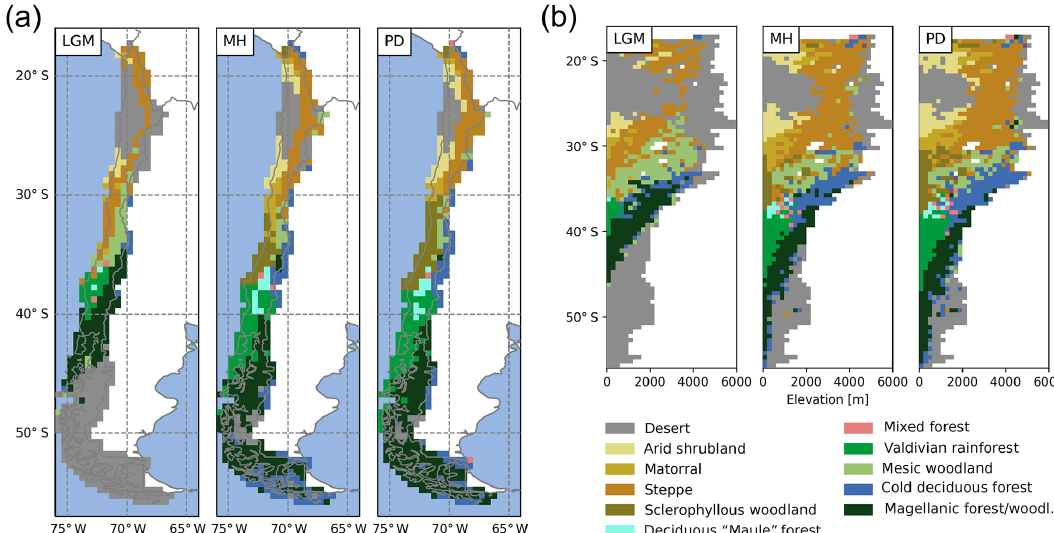
Figure 5. (a) Spatial and (b) altitudinal distribution of biomes for Last Glacial Maximum (LGM), the mid-Holocene (MH), and the present day (PD) (for the biome classification decision tree see Fig. C1).